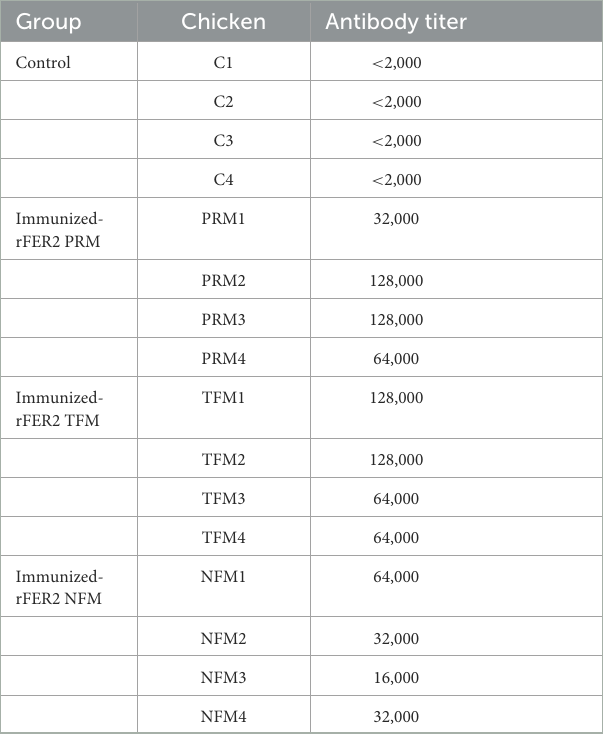
TABLE 2 Antibody titers in plasma samples from chickens immunized with recombinant ferritin 2. Group